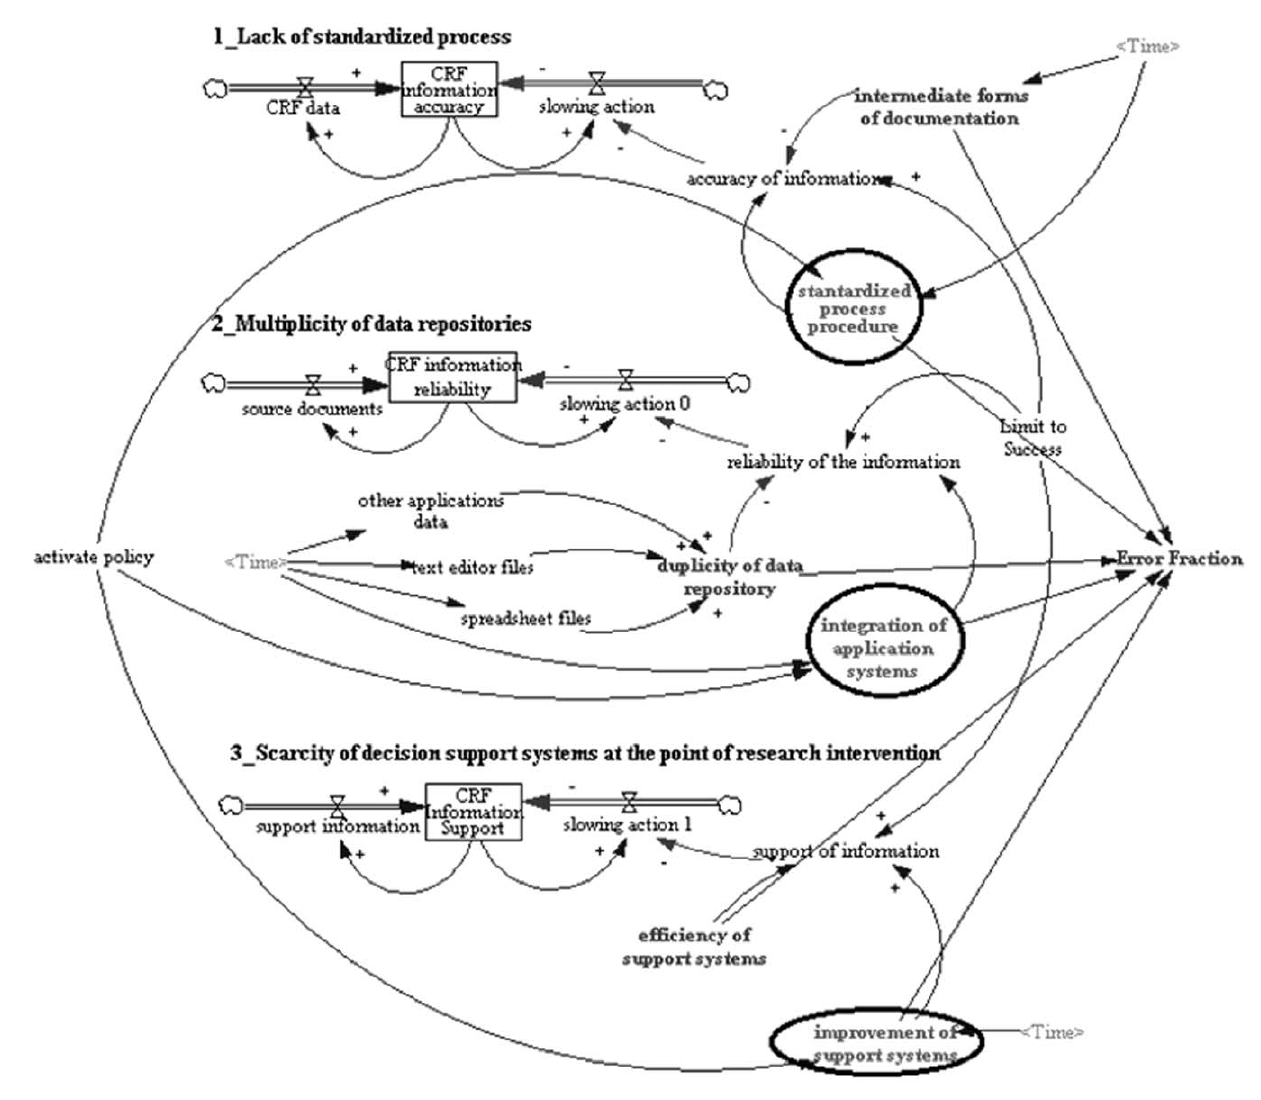
Figure 3. Dynamic model with the policies suggested (circled). Available for best visualization in http://goo.gl/XydTd.